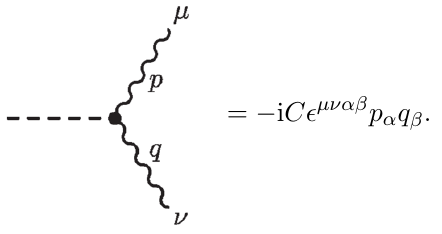
Figure 2 . Feynman rule for the interaction between pion and electromagnetic (cid:12)elds, following from the Lagrangian (2.2). The dashed line stands for the (cid:30) (cid:12)eld, whereas the wavy lines for the A (cid:12)eld. The momenta p and q (cid:13)ow out of the